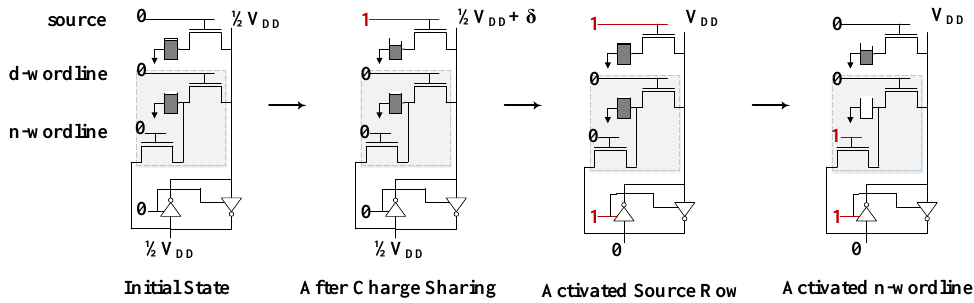
Figure 11. Bitwise NOT using a dual-contact cell (DCC) connected to a sense amplifier (adapted from